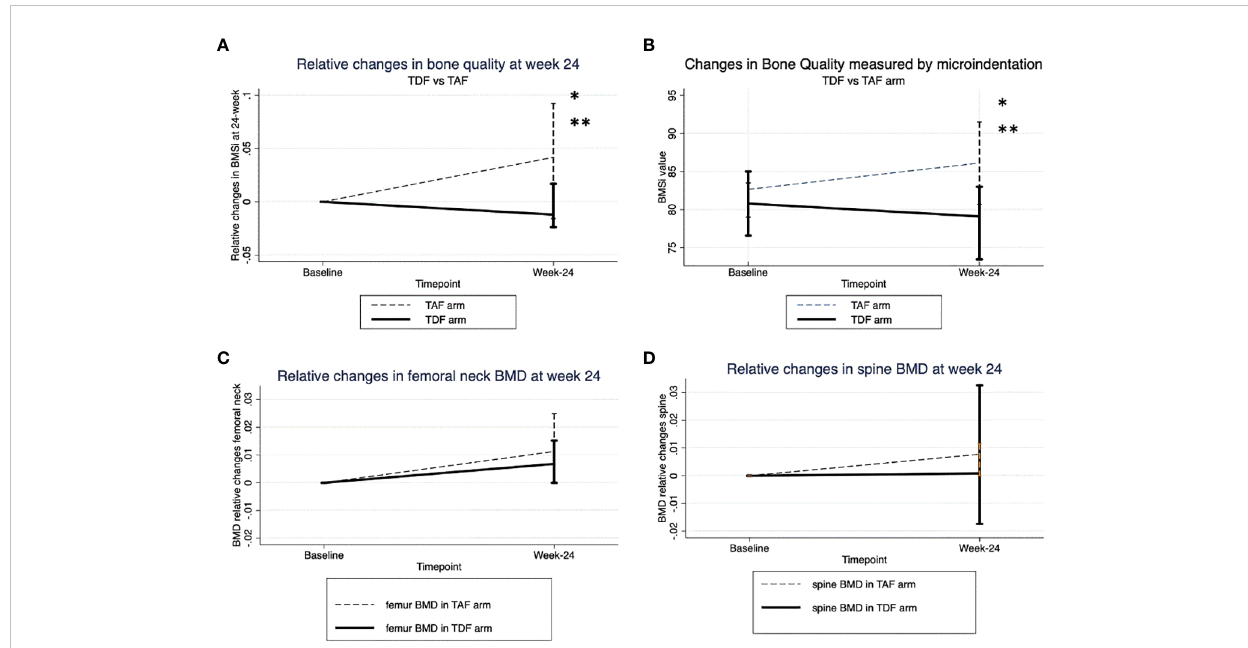
FIGURE 1 (A) Absolute changes in BMSi between two arms. *p-value at week -24 respect to baseline in TAF arm. **p-value at week-24 between TDF and TAF arms. (B) Relative changes in bone quality. (C) Relative changes in Bone mineral density at femoral neck. (D) Relative changes in Bone mineral density at spine